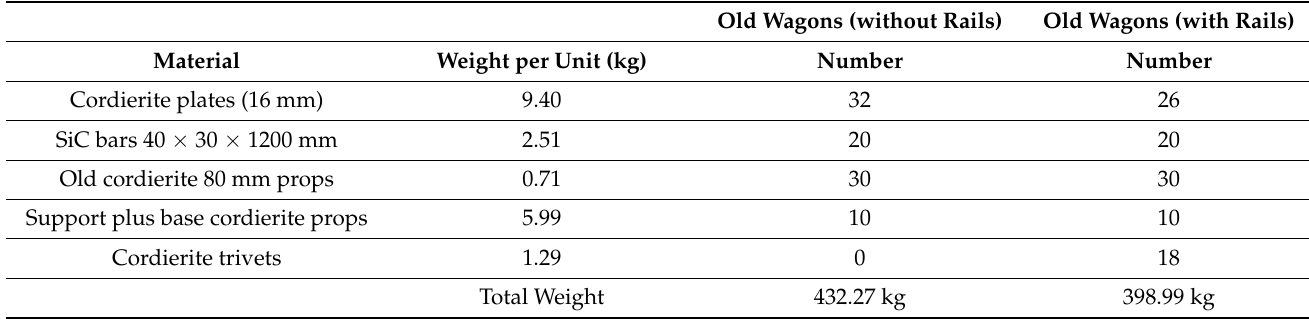
Table 8. Constitution of old wagons and their respective weights.